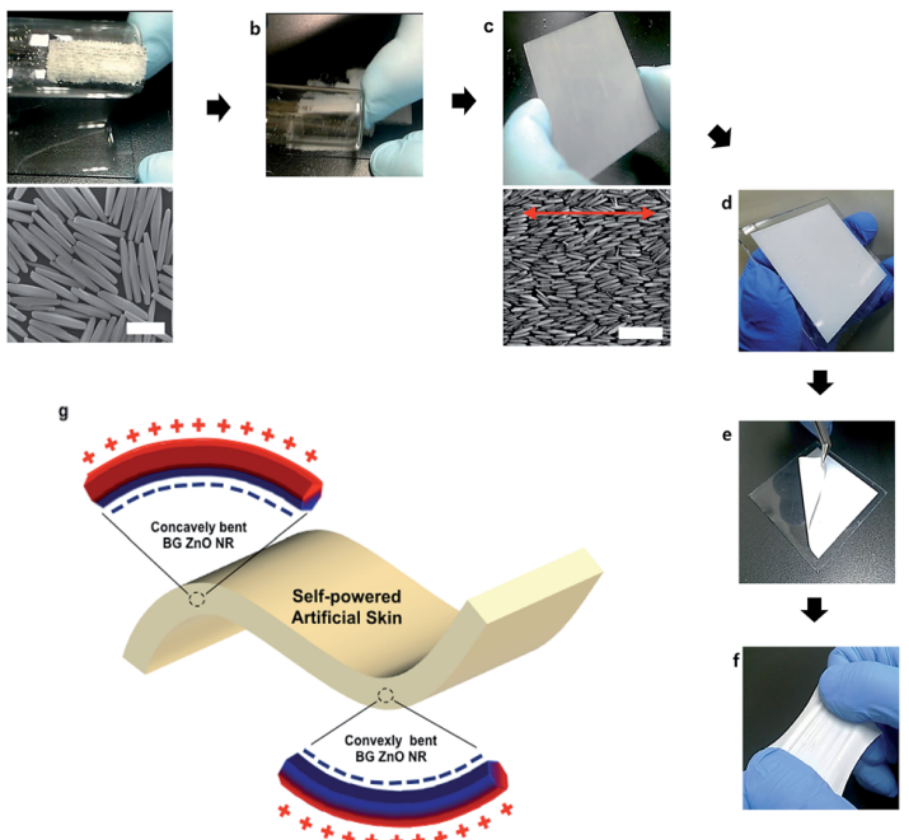
Figure 8. Self-powered artificial skin (SPAS) fabrication with a bi-axially grown ZnO nanorod array on a PDMS film through one-direction rubbing. ( a ) Bi-axially-grown ZnO NR powder on a velvet cloth, which was attached to one side of a round glass tube. The bottom image shows bi-axially- grown (BG) ZnO NRs from a hydrothermal synthesis after thermal annealing at 400 °C for 2 h (scale bar = 2 μm). ( b ) BG ZnO NRs rubbing in one-direction on a PDMS coated slide glass. ( c ) Single monolayer formation of BG ZnO NRs through rubbing. The bottom image indicates a nematic-like array of the BG ZnO NRs (red arrow indicates the rubbing direction; scale bar is 6 μm). ( d ) Seven layers of the SPAS on a glass substrate. ( e ) Detachment of the SPAS from the glass substrate. ( f ) Photograph demonstrating how the SPAS is flexible (in ( e )) and stretchable. ( g ) Schematic 3D dia- gram describing the piezoelectric potential generation of a bent SPAS. Reprinted with permission from Ref. [17]. Copyright 2014 Royal Society of Chemistry.